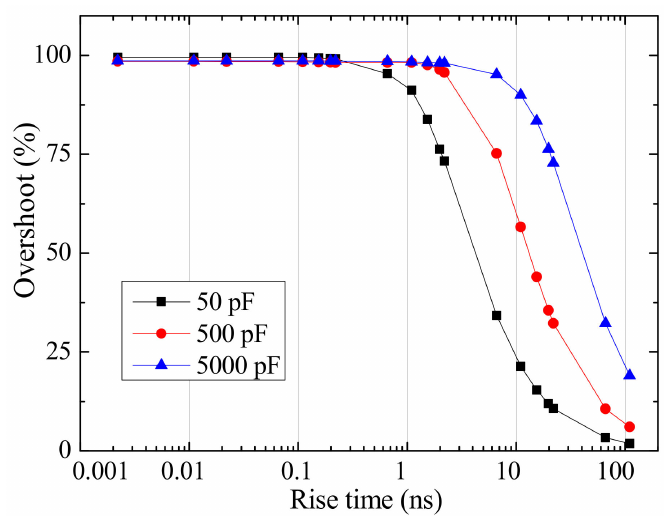
Figure 10. Overshoot under different rise times and